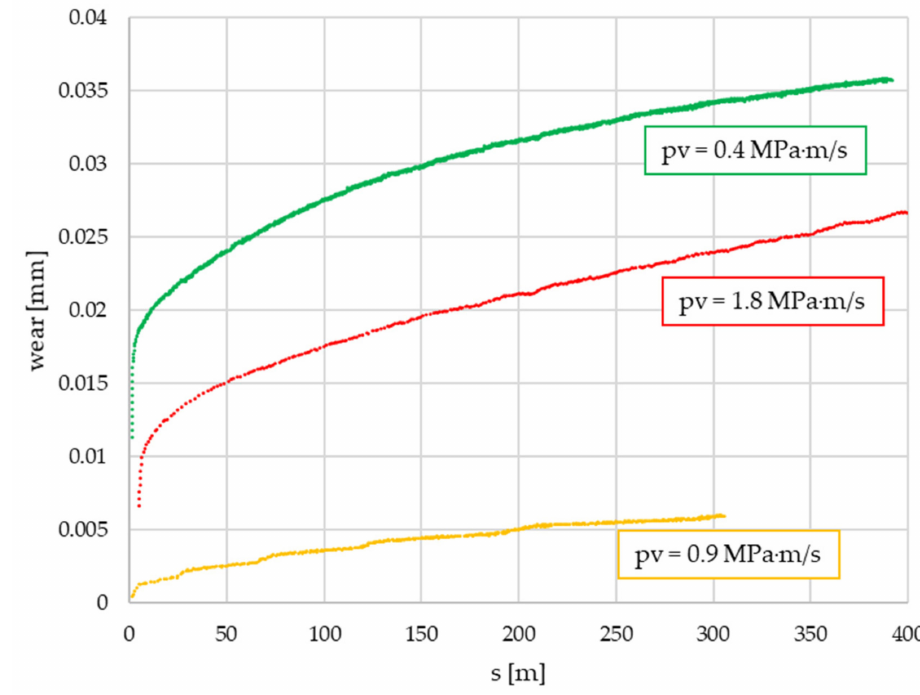
Figure 10. Wear values during the PoD test of a specimen category.